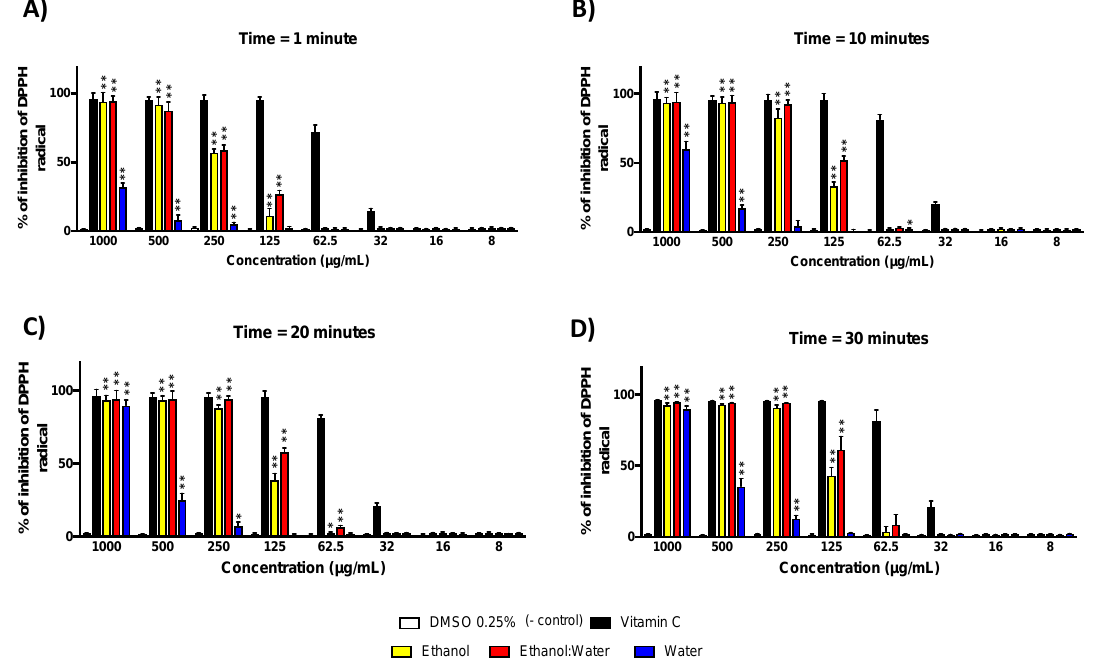
Figure 2. DPPH radical inhibition of three LT extracts at different concentrations (1000 µg/mL–8 µg/mL and at four time points: ( A ) time = 1 min, ( B ) time = 10 min, ( C ) time = 20 min and ( D ) time = 30 min. The concentration of the DPPH radical was 100 µM. The absorbance was measured at 517 nm. Each bar represents the average of three replicates and the error bars represent the standard deviation. The asterisks indicate a significant difference between the treatment and negative control (* p < 0.05 and ** p < 0.001).